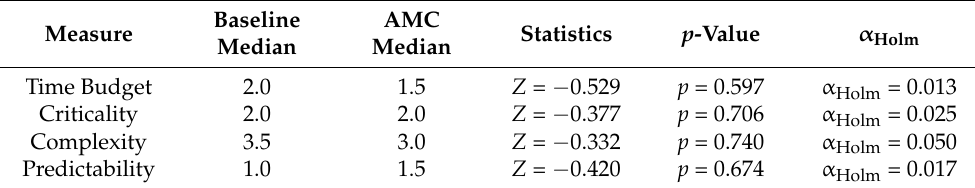
Table 5. Median values and statistics comparing subjects’ ratings of the malfunction